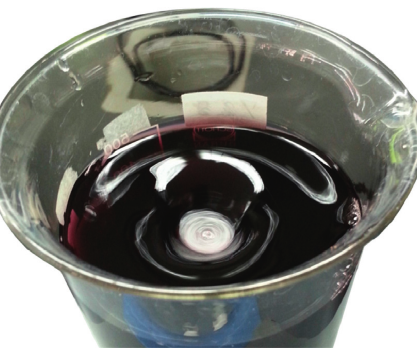
Figure 2: Colloidal solutions obtained by tannin-assisted synthesis of AuNPs using chloroauric acid as a